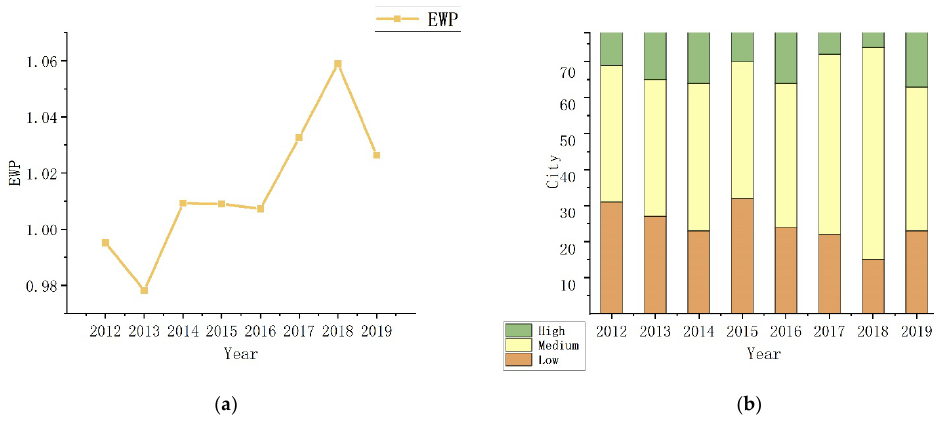
Figure 3. ( a ) Average EWP 2012–2019; ( b ) Classification of EWP 2012–2019.